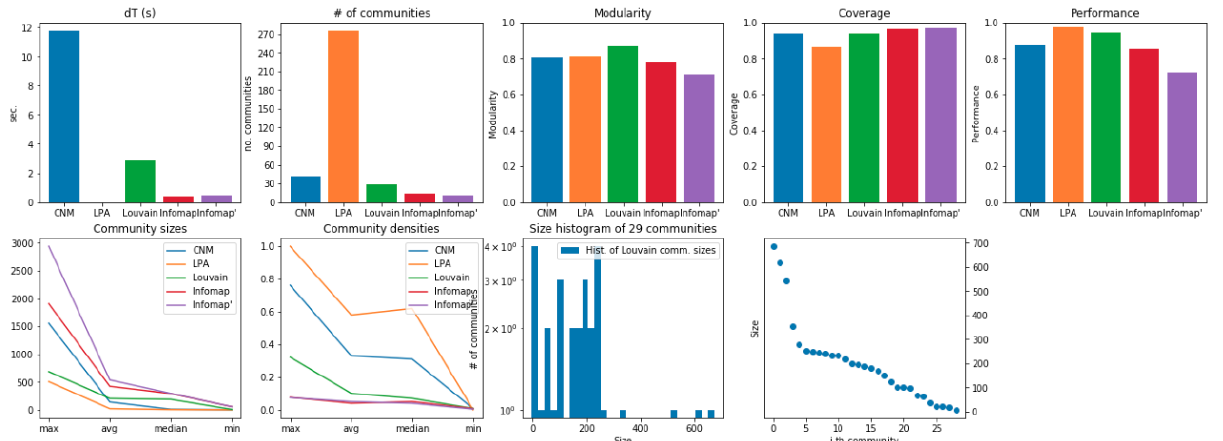
Figure 4. Community analysis of the Politicians network: the bar plots represent the runtime, number of communities, scores of modularity, coverage and performance, sizes of communities and their densities according to each algorithm. Additionally, a size histogram of Louvain communities is